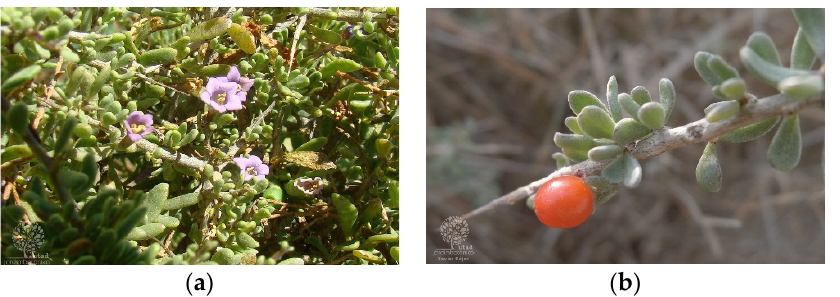
Figure 3. Lycium schweinfurthii Dammer: ( a ) general aspects of the aerial parts (source: https://www.plantarium.ru/lang/en/page/image/id/652684.html) (accessed on 24 September 2022); and ( b ) general aspects of fruits (source: https://www.plantarium.ru/lang/en/page/image/id/627979 .html).